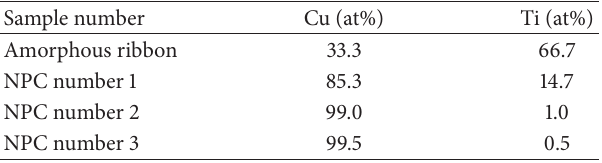
Table 1: Chemical compositions of the NPC samples test by EDS.